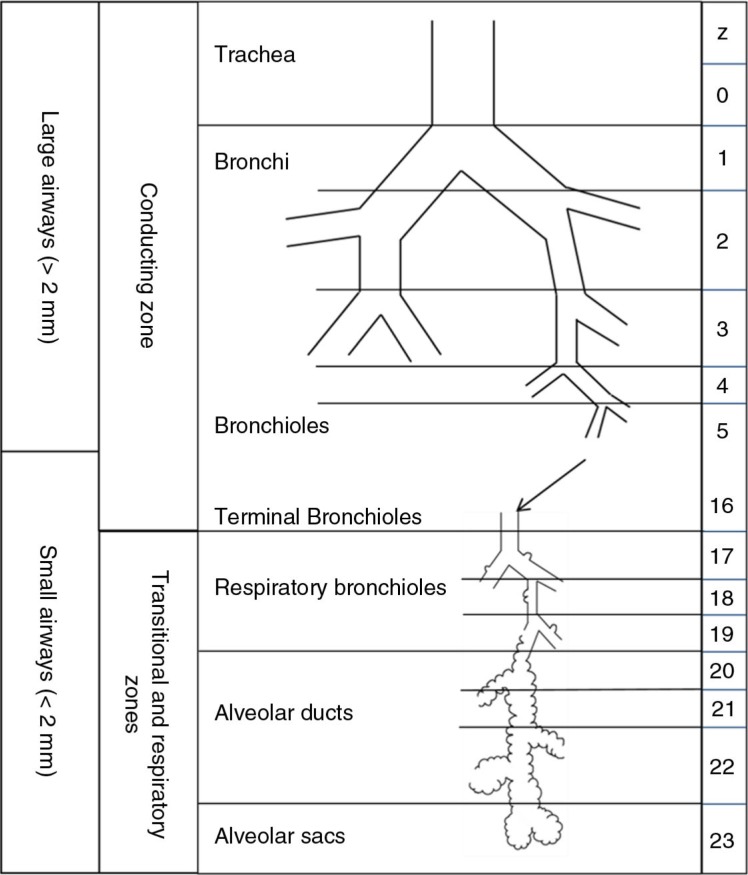
Airway generations (adapted from ref. 1).